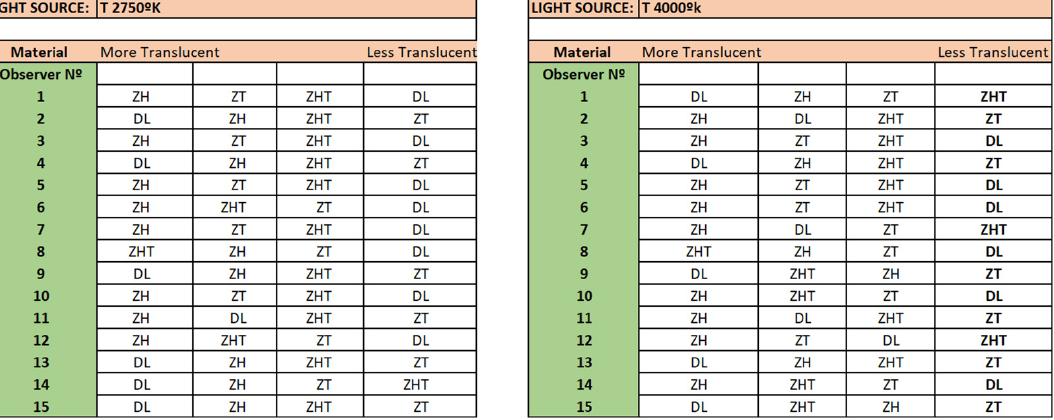
Figure 4. Visual evaluation of the four materials under both light sources.